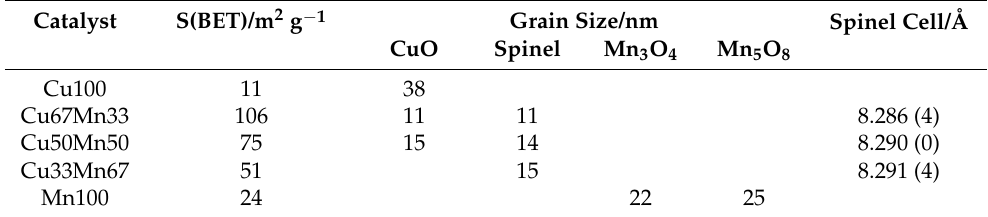
Figure 2. Powder XRD patterns of the Cu-Mn catalysts. CuO tenorite ( haussmannite ( ♦ ), Mn 5 O 8 ( ∆ ). Table 4. Textural characterisation and spinel crystallographic data of Cu-Mn oxide catalysts. Catalyst S(BET)/m 2 g − 1 Grain